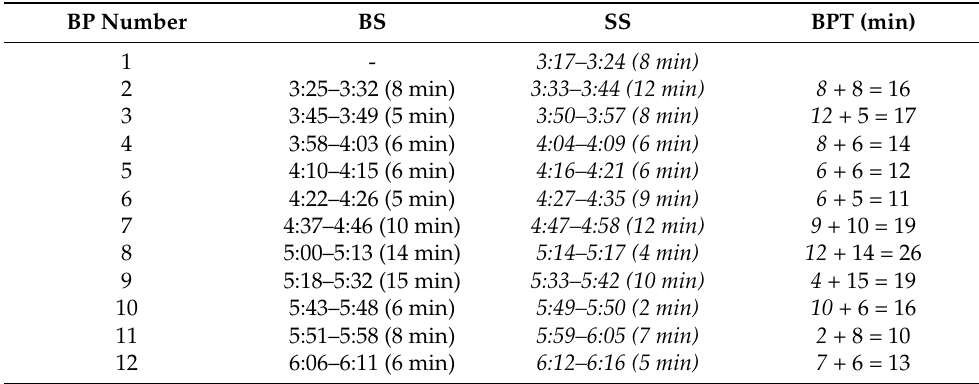
Table 4. Statistics of BPT during the rain on 18 to 19 August 2021.